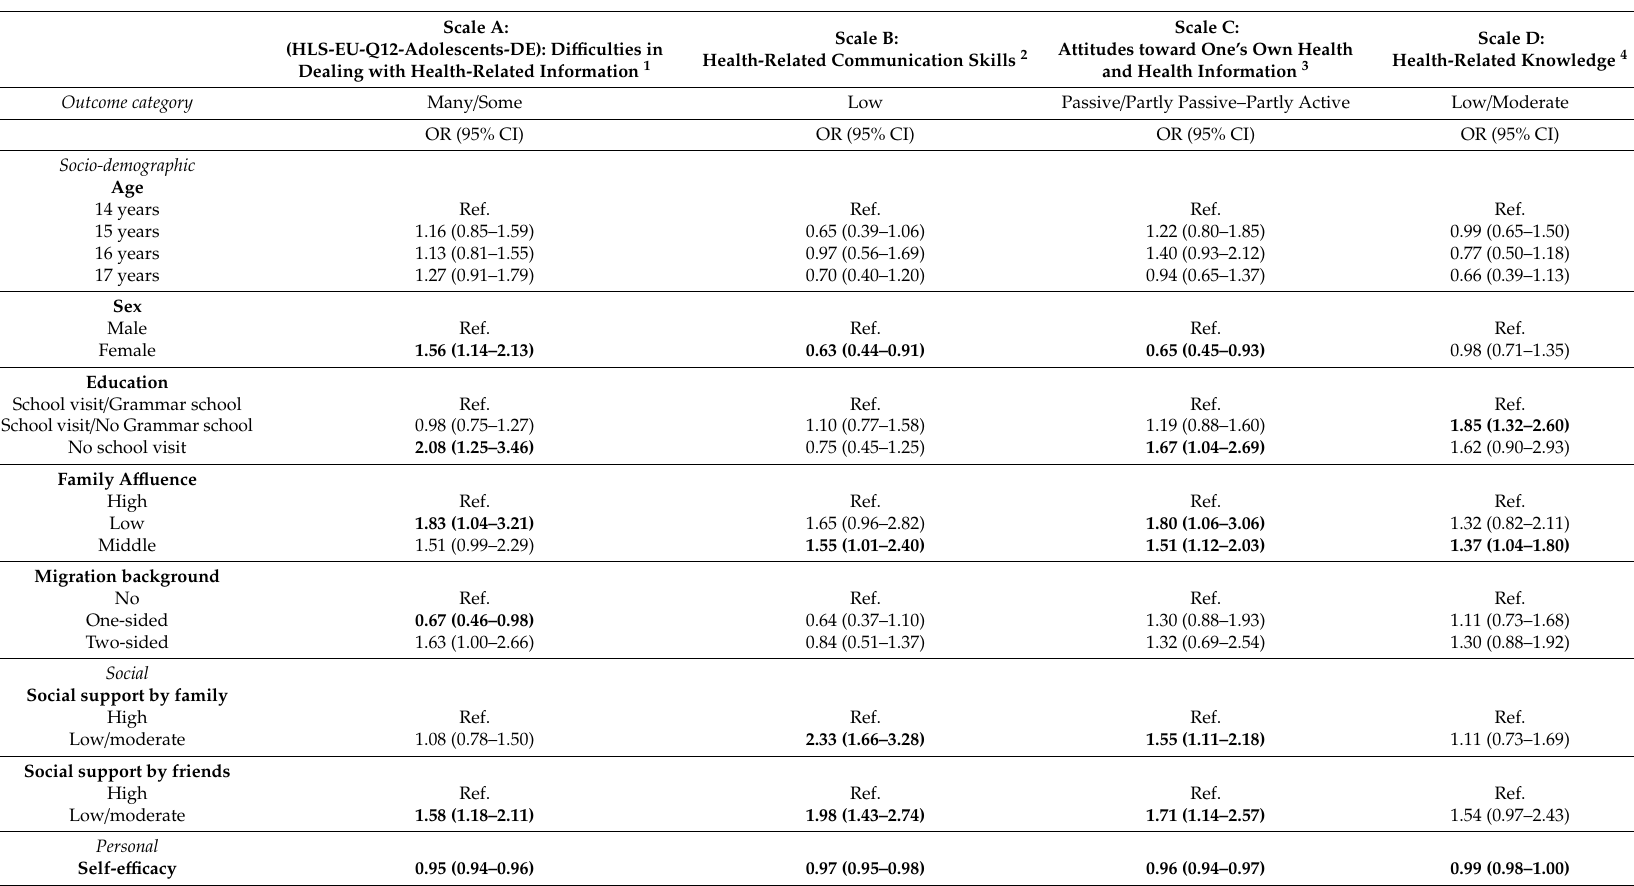
Table 7. Odds ratios between socio-demographic, social and personal factors and poor health literacy levels among adolescents aged 14–17 ( n = 1202) based on GeKoJu 2019